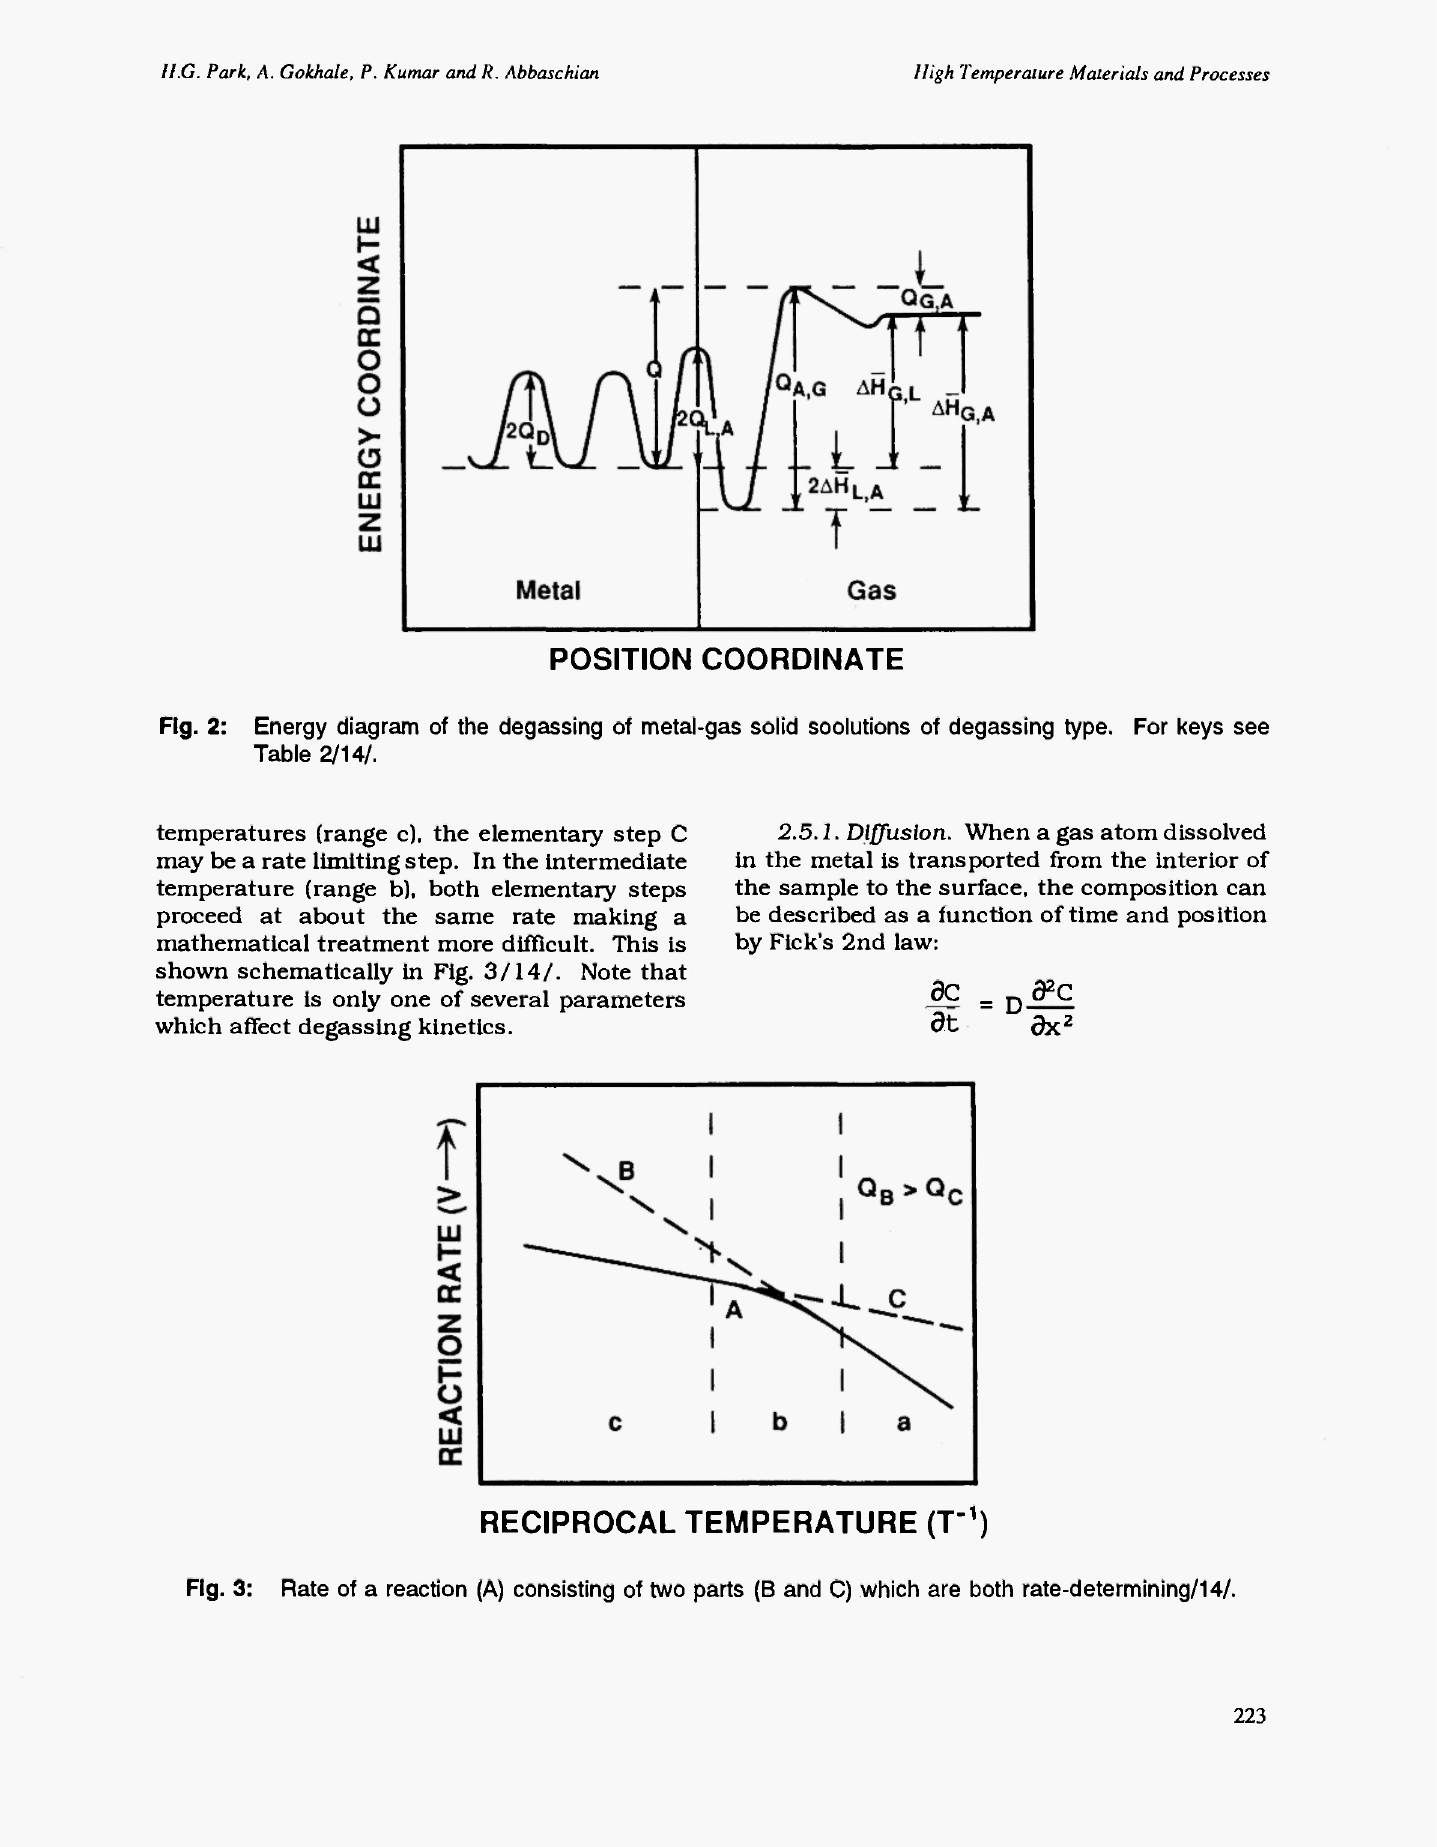
Fig. 3: Rate of a reaction (A) consisting of two parts (B and C) which are both